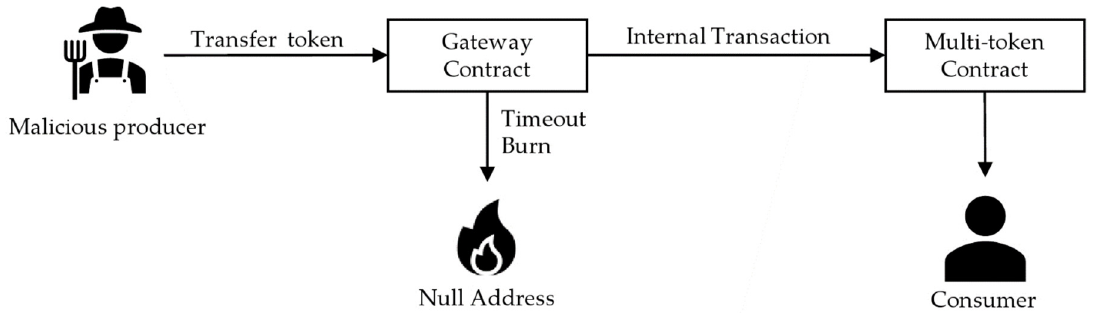
Figure 11. Timeout logic included in gateway